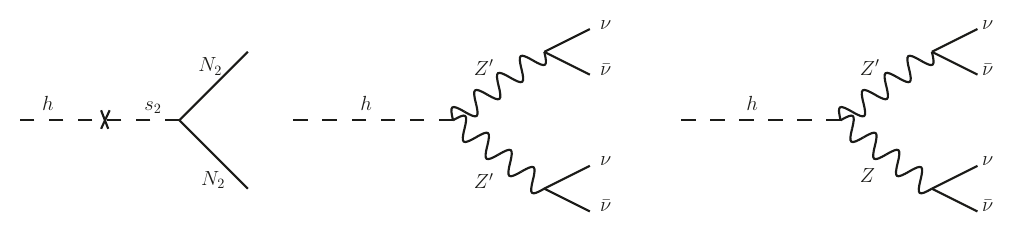
Figure 29 . Invisible Higgs decay